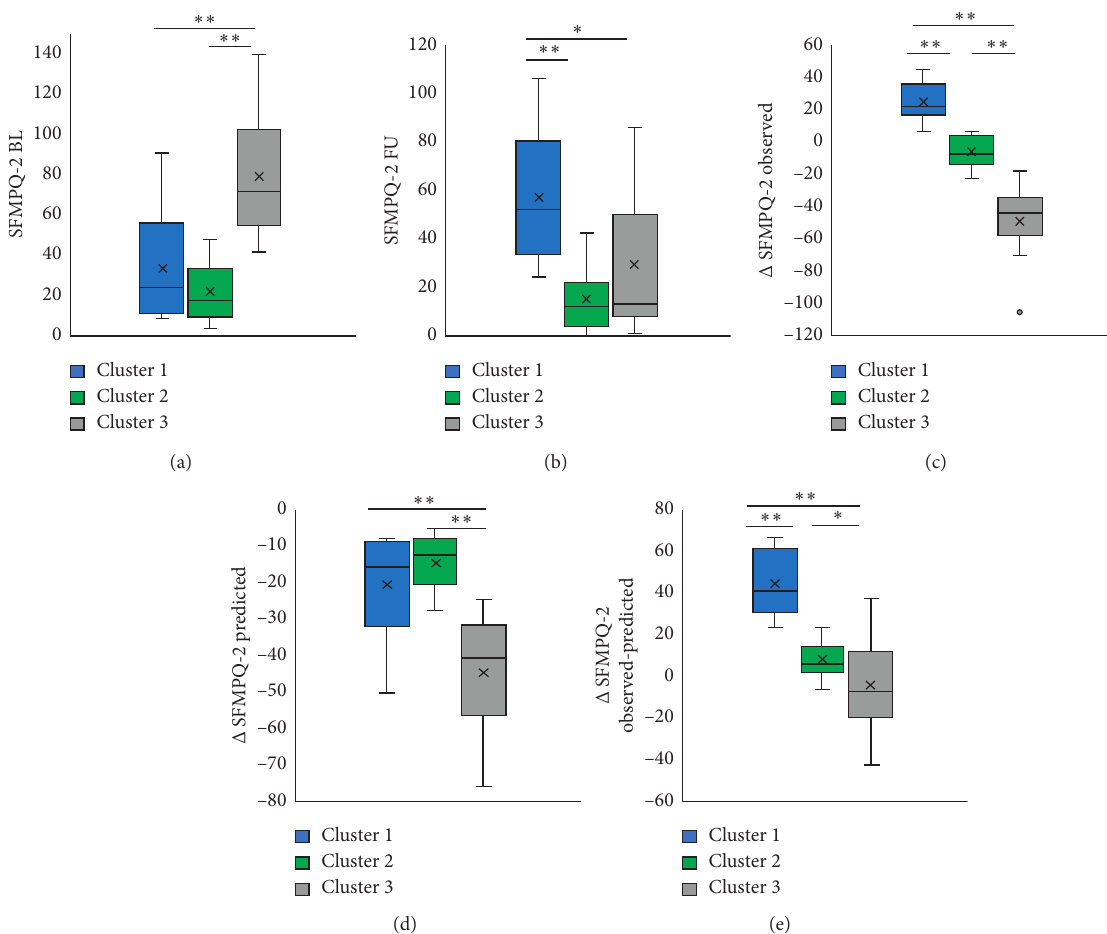
Figure 3: The difference of SFMPQ-2 between clusters. (a) The difference of SFMPQ-2 BL between clusters. (b) The difference of SFMPQ-2 FU between clusters. (c) The difference of ∆ SFMPQ observed between clusters. (d) The difference of ∆ SFMPQ-2 predicted between clusters. (e) The difference of ∆ SFMPQ-2 observed-predicted between clusters. ∗∗ : p < 0 . 01. ∗ : p < 0 . 05. Abbreviations: SFMPQ-2, Short-Form McGill Pain Questionnaire-2; BL, baseline; FU, follow-up; ∆ , follow-up score minus the initial